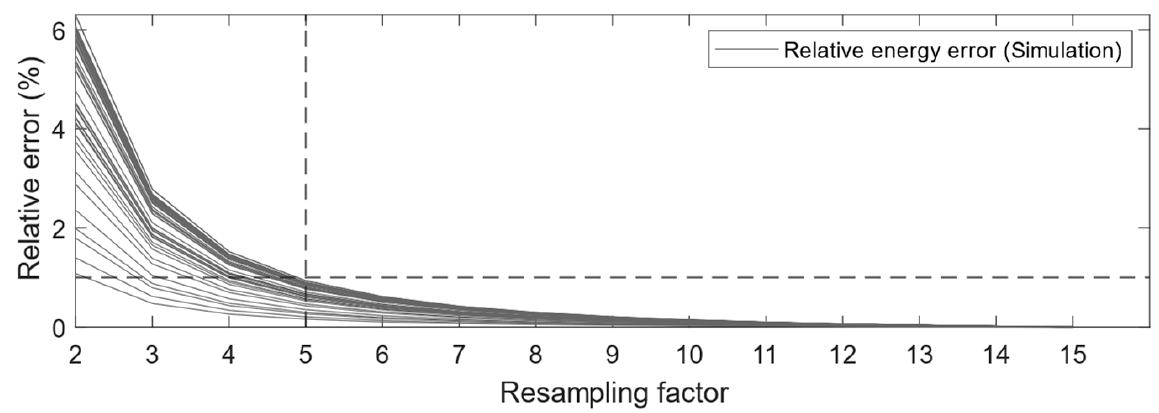
Figure 6. Relative error in energy simulations according to the resampling factor of the acceleration data. One line is drawn for each of the 17 sensors.